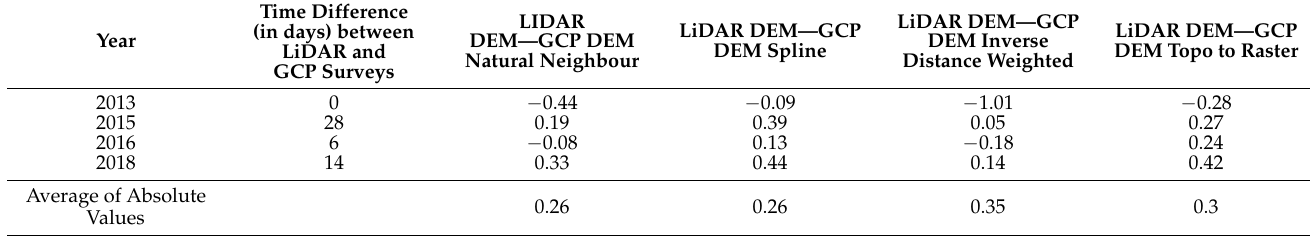
Table 3. Average elevation difference (in meters) of the Canin East Glacier Ice Patch (GIP) digital elevation model (DEM) of Difference (DoD) between LiDAR derived DEM through Delaunay triangulation and GCPs-derived DEM using natural neighbor, spline, inverse distance weighted and topo to raster interpolation